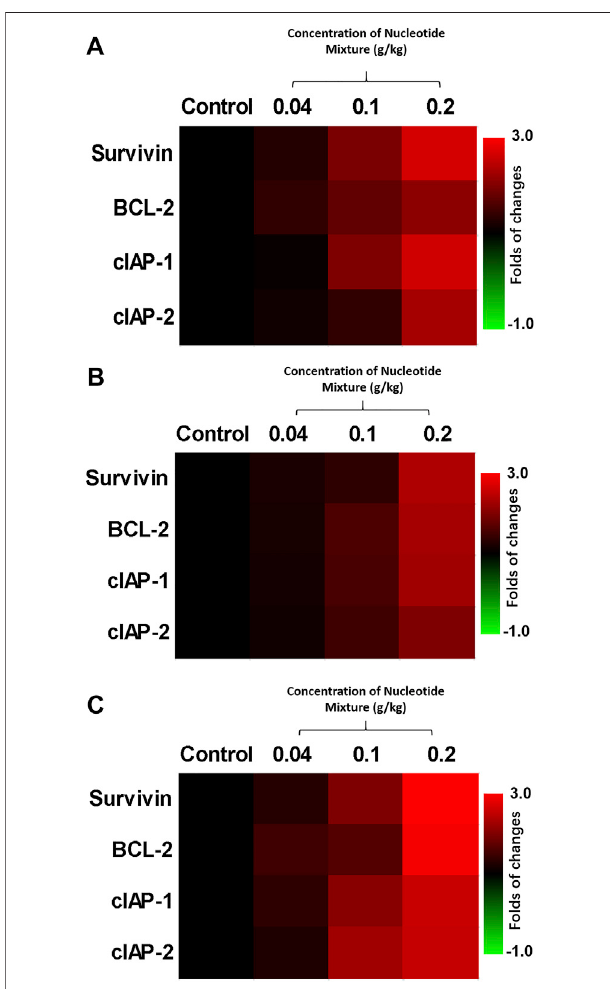
FIGURE 5 | Protective effect of the SNM on cells isolated from the peripheral-blood lymphocytes of healthy volunteers (RT-qPCR). Peripheral- bloodlymphocyteswereisolatedfromblooddonatedfromhealthyvolunteers. Then, T cells (A) , B cells (B) , and NK cells (C) were obtained by sorting. Cells were treated with different doses of the SNM, and the effects on expression of BCL-2, survivin, cIAP-1, and cIAP-2 in cells were examined by RT-qPCR.Resultsareshownasheatmapsofthefoldchangeinexpressionof pro-survival and anti-apoptotic factors in each group compared with the control